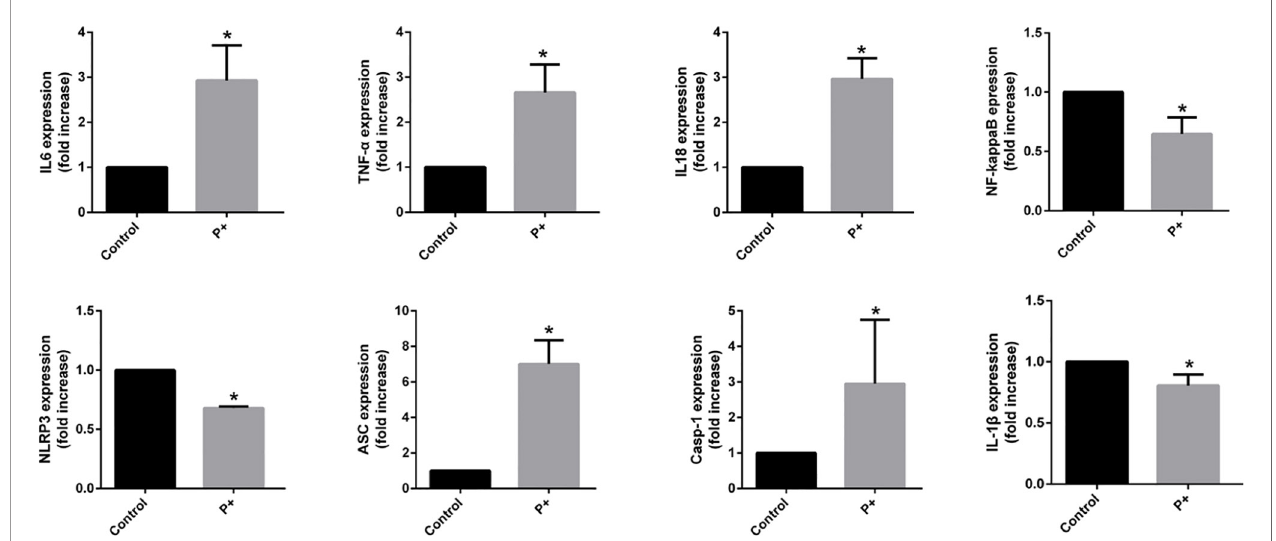
FIGURE 3 | The qRT-PCR results of the expression of in fl ammatory cytokines in oral tumor-bearing mice, including interleukin (IL)-6, tumor necrosis factor (TNF)- a , nuclear factor (NF)- k B, NOD-, LRR- and pyrin domain-containing protein 3 (NLRP3), apoptosis-associated speck-like protein containing a CARD (ASC), caspase-1, IL-1 b , and IL-18. *p <